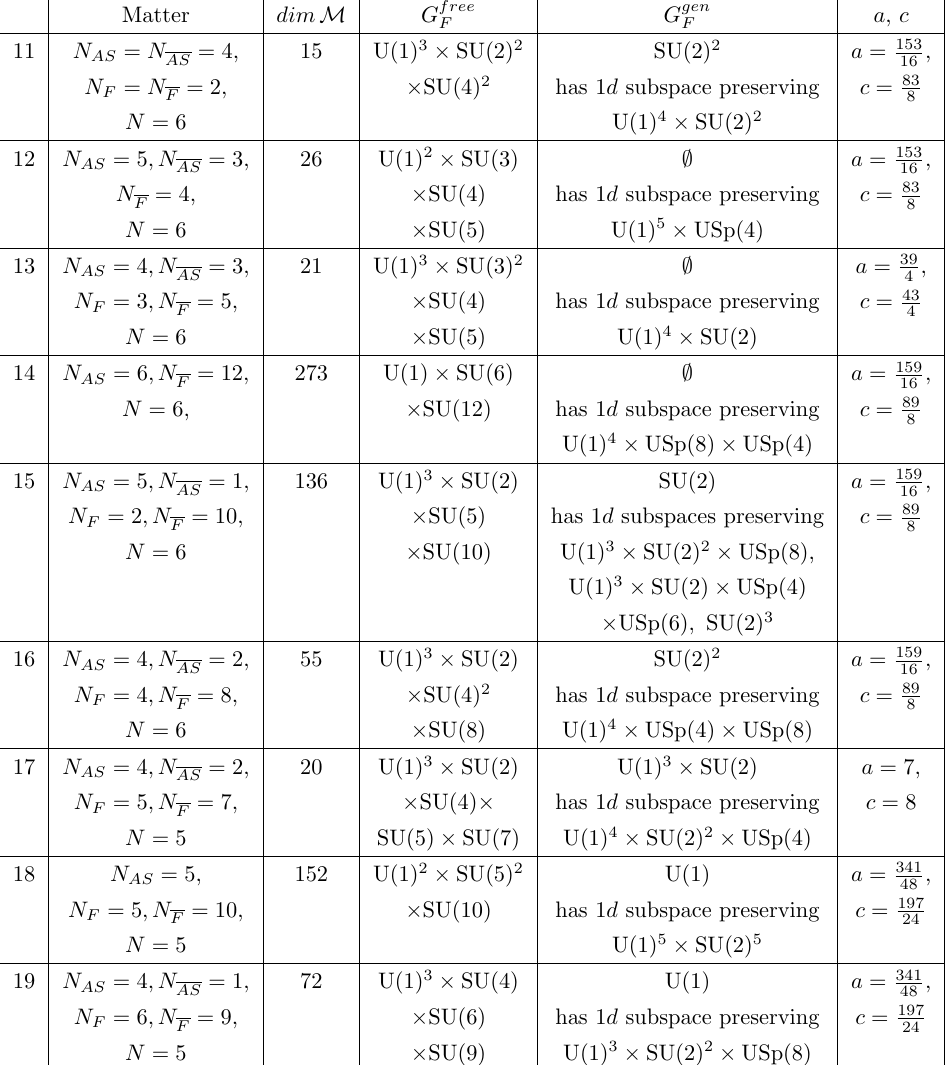
Table 7 . Cases involving an SU( N ) gauge group with fundamental and antisymmetric chiral (cid:12)elds only,